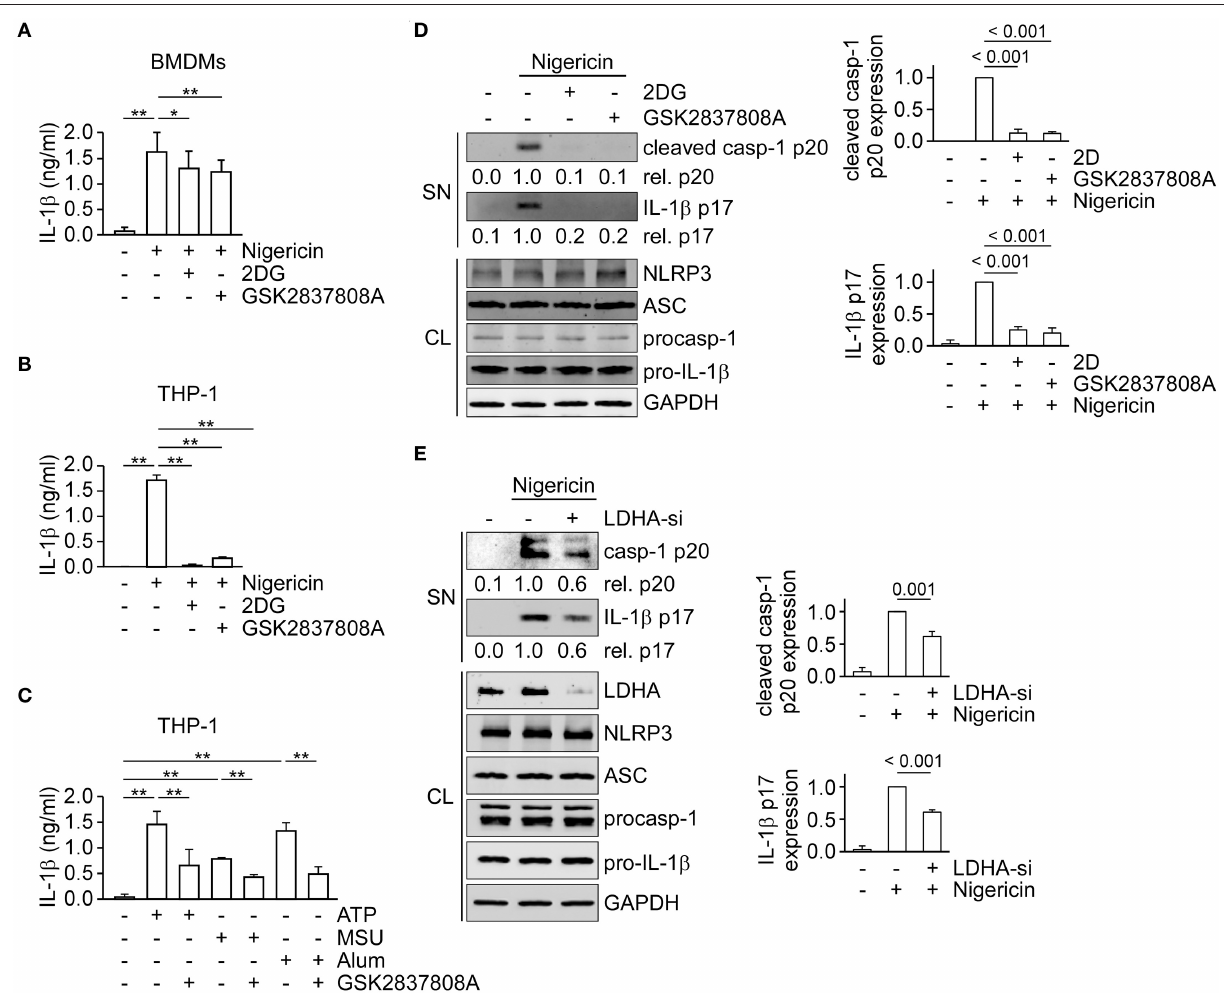
FIGURE 1 | Inhibition of lactate dehydrogenase prevents NLRP3 inflammasome activation. (A) ELISA was used to determine the IL-1 β levels in culture supernatants of mouse bone marrow-derived macrophages (BMDMs) that had been pretreated with 2DG or GSK2837808A for 1h, followed by stimulation with nigericin for 45min. (B) Determination by ELISA of IL-1 β in the culture supernatant of THP-1-derived macrophages that had been pretreated with 2DG or GSK2837808A for 1h, followed by stimulation with nigericin for 45min. (C) Determination by ELISA of IL-1 β in the culture supernatant of THP-1-derived macrophages that had been pretreated with GSK2837808A for 1h, followed by stimulation with ATP, MSU, or alum for 4h. (D) Immunoblot analysis of NLRP3 inflammasome molecules in culture supernatants (SN) and cell lysates (CL) of THP-1-derived macrophages that had been treated with or without 2DG or GSK2837808A for 1h and then stimulated with nigericin for 45min. The densitometric analysis of caspase-1 (p20) and IL-1 β (p17) was shown in the right panels. (E) Immunoblot analysis of NLRP3 inflammasome molecules in cell supernatants and cell lysates of THP-1-derived macrophages treated with LDHA- or negative control- siRNA, and then stimulated with nigericin for 45min. The densitometric analysis of caspase-1 (p20) and IL-1 β (p17) was shown in the right panels. * P < 0.05; ** P < 0.01. All results are presented as the mean ± SD of data from three independent experiments ( n = 3 per group), and were analyzed with the ANOVA test followed by post hoc